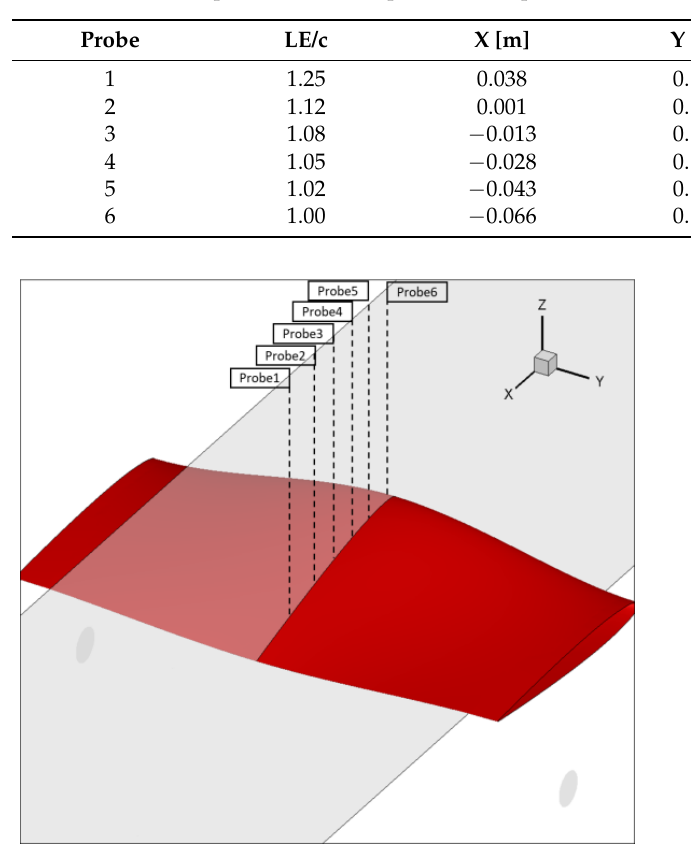
Table 7. Location of probe to monitor pressure at top wall.